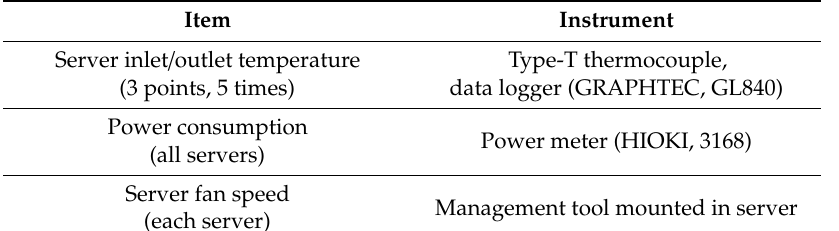
Table 4. Measured items and measurement instruments (experiments A and B).